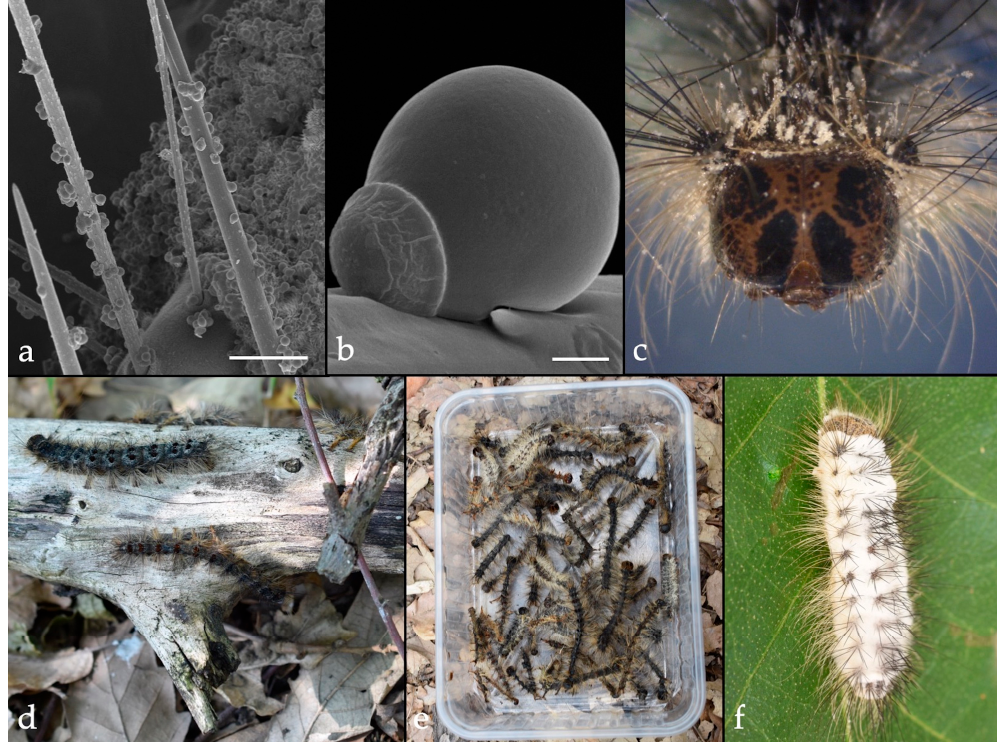
Figure 3. Entomopathogenic fungi, Entomophaga maimaiga ( a - e ) and Beauveria bassiana ( f ) on